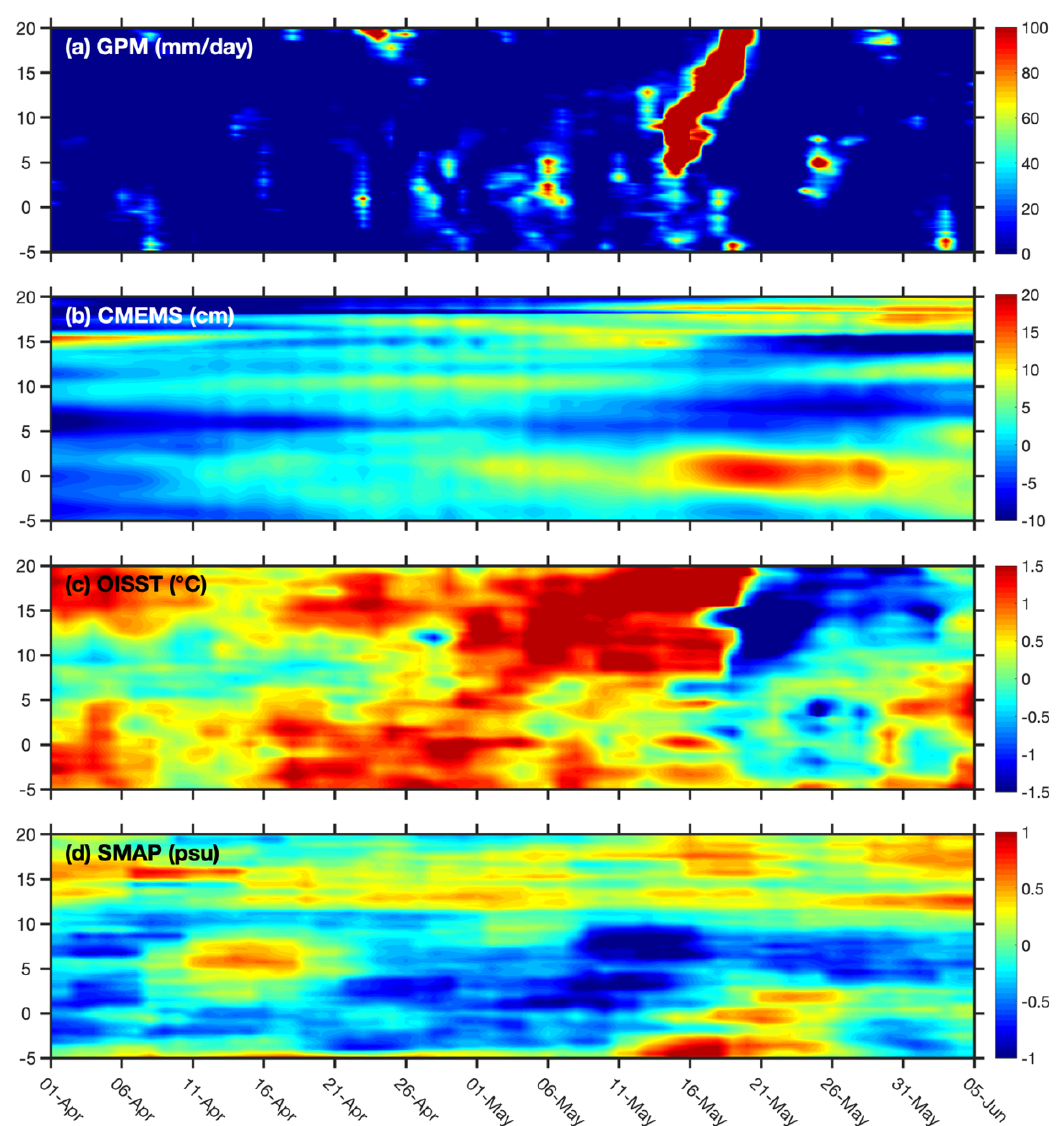
Figure 8. Time–latitude plots of ( a ) GPM precipitation rate (mm / day), ( b ) CMEMS SLA (cm), ( c ) OISST (°C), and ( d ) SMAP SSS (psu) in the Bay of Bengal (86–88°E, − 5–20°N) from April 1 to May 31, 2020 with the seasonal cycle removed.